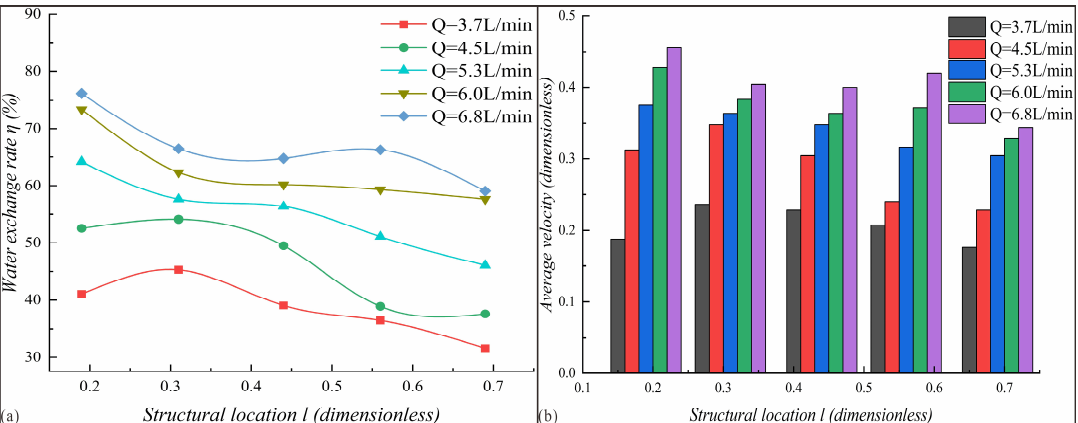
Figure 11. Calculation results for the rectangular column: ( a ) water exchange rate; ( b ) average velocity.